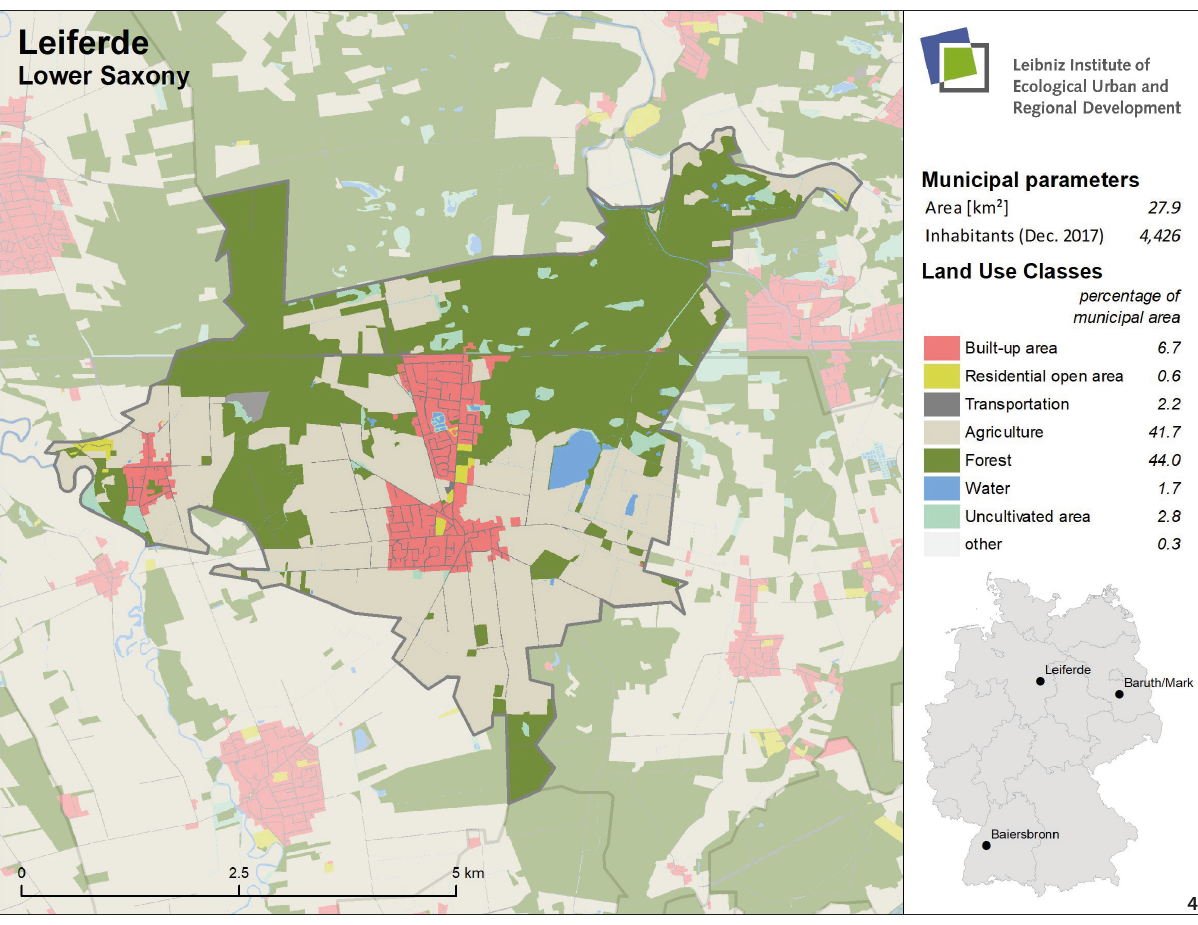
Figure 4 Land use in the rural municipality of Baiersbronn (Source: IOER Monitor 2019, Geobasis-DE/BKG